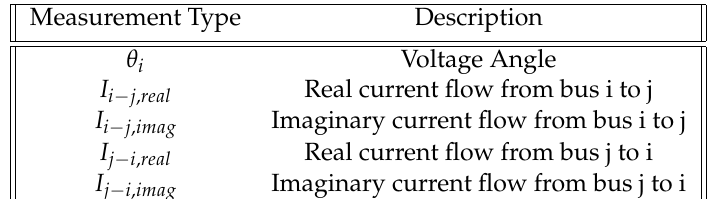
Table 2. Measurement types from PMUs